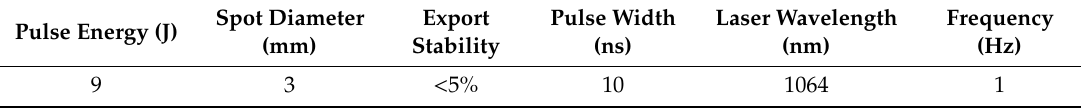
Table 3. Processing parameters used in RT-LSP and WLSP.